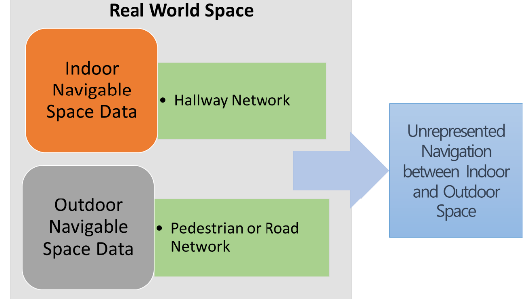
Figure 1 . Representation gap in representing the real-world using spatial